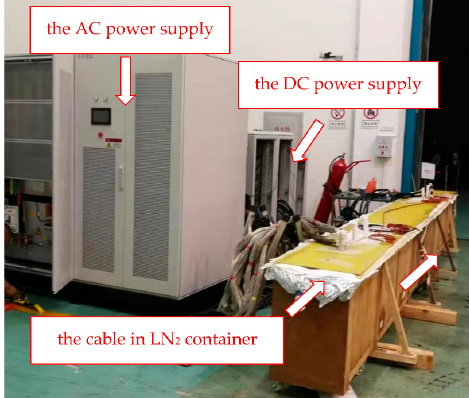
Figure 13. Photo of the critical current test and AC operating current test.